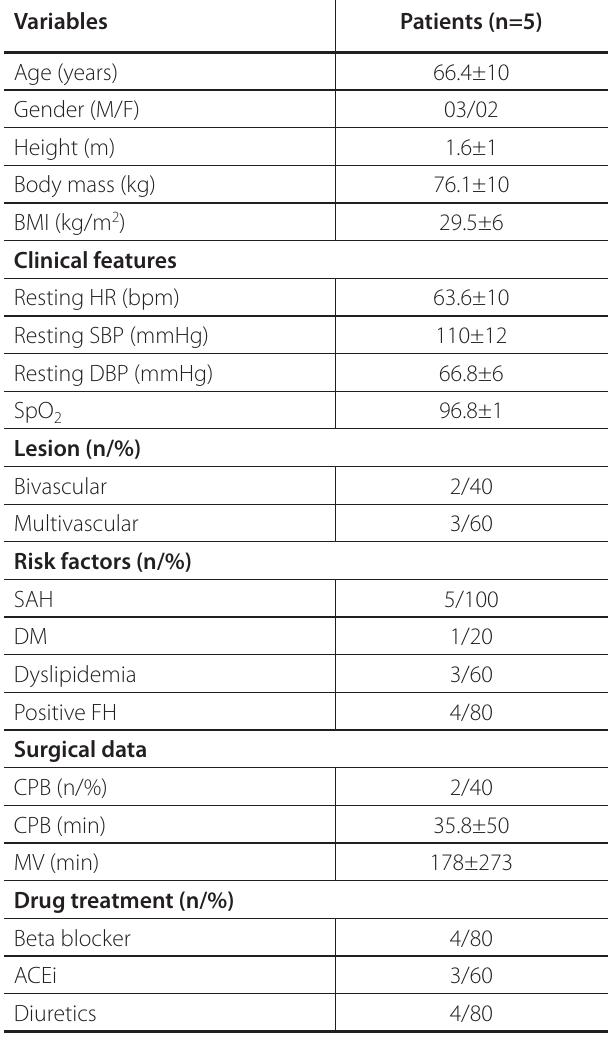
Table 1 . Anthropometric data and clinical characteristics of the